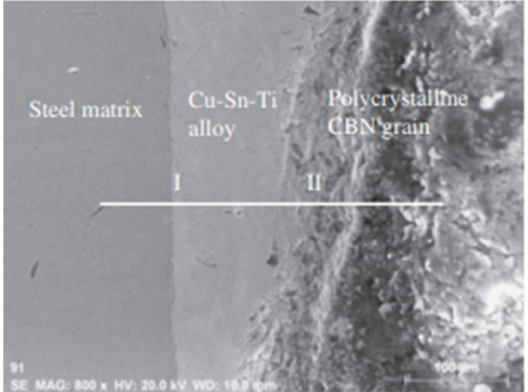
Figure 36. Interface microstructure of steel matrix/Cu–Sn–Ti alloy/polycrystalline CBN grain